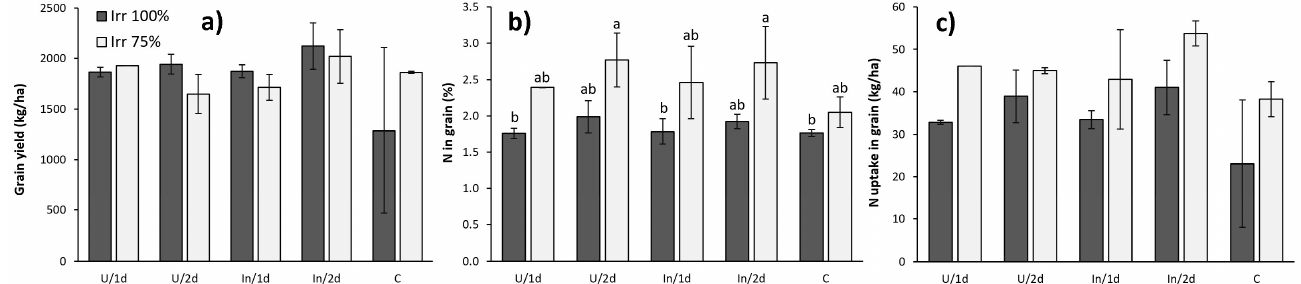
Figure 5. ( a ) Wheat grain yield (dry matter), ( b ) N concentration in grain, and ( c ) N uptake in grain for the different treatments. Bars represent the standard error. Letters indicate statistical differences between treatments ( p < 0.05). Treatments were a combination of urease inhibitor use (In), simple urea use (U), or no fertilizer (C), with fertilizer application in one (1 d) or two (2 d) dressings and optimally irrigated (100%) or sub-optimally irrigated (75%).